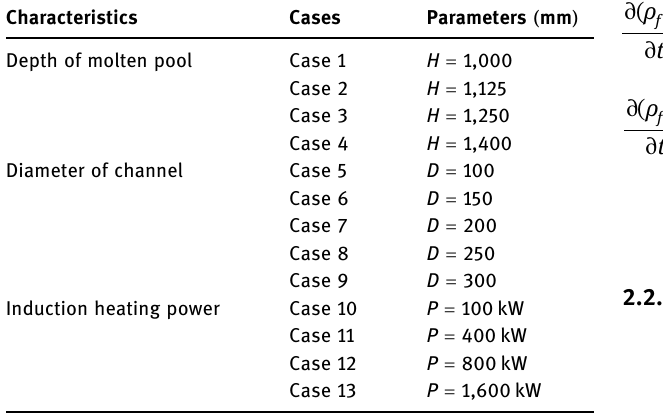
Table 1: Simulation performed for following cases